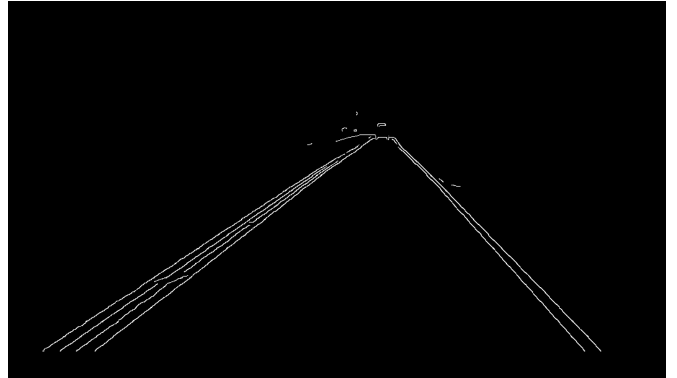
Figure 10. Canny edge detector output image.